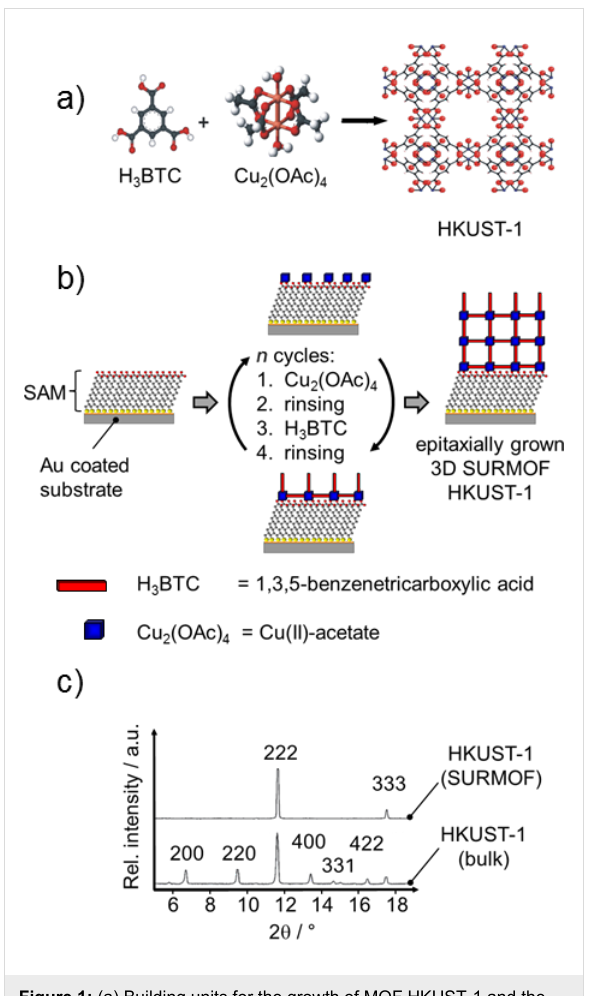
Figure 1: (a) Building units for the growth of MOF HKUST-1 and the unit cell of HKUST-1. (b) The principle of the layer-by-layer growth of a surface anchored MOF. (c) XRD results for a polycrystalline particu- late HKUST-1 sample and the corresponding SURMOF. The